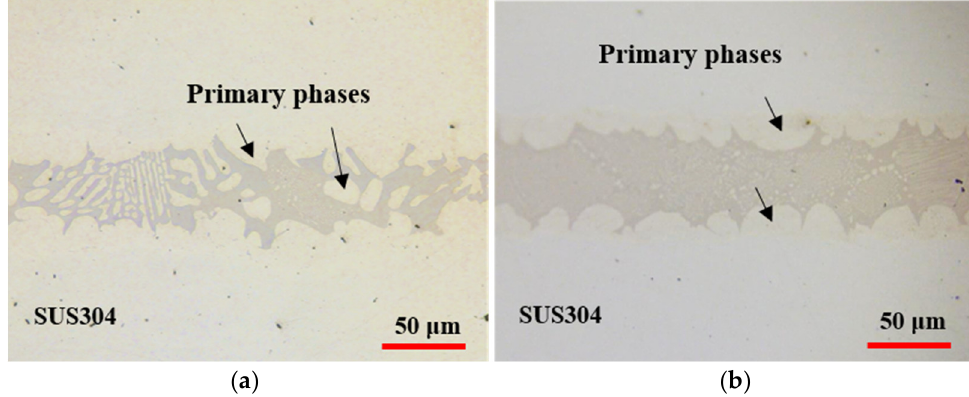
Figure 8. OM images of cross sections of joints brazed with electrodeposited Ni-13.4Cr-11.6P alloy coating ( a ) and electrodeposited Ni-11P alloy coating ( b ).